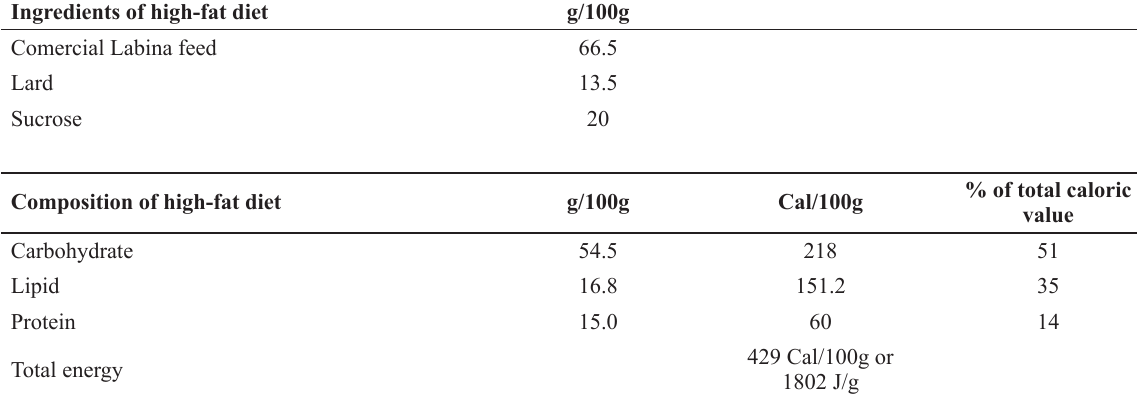
Ingredients and chemical composition (g/100 g) of high-fat